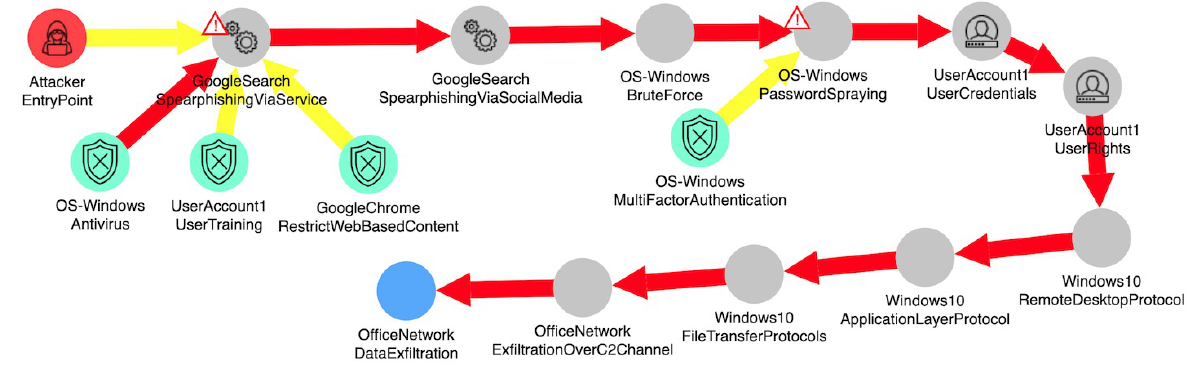
Figure 11. Attack path to perform data exfiltration